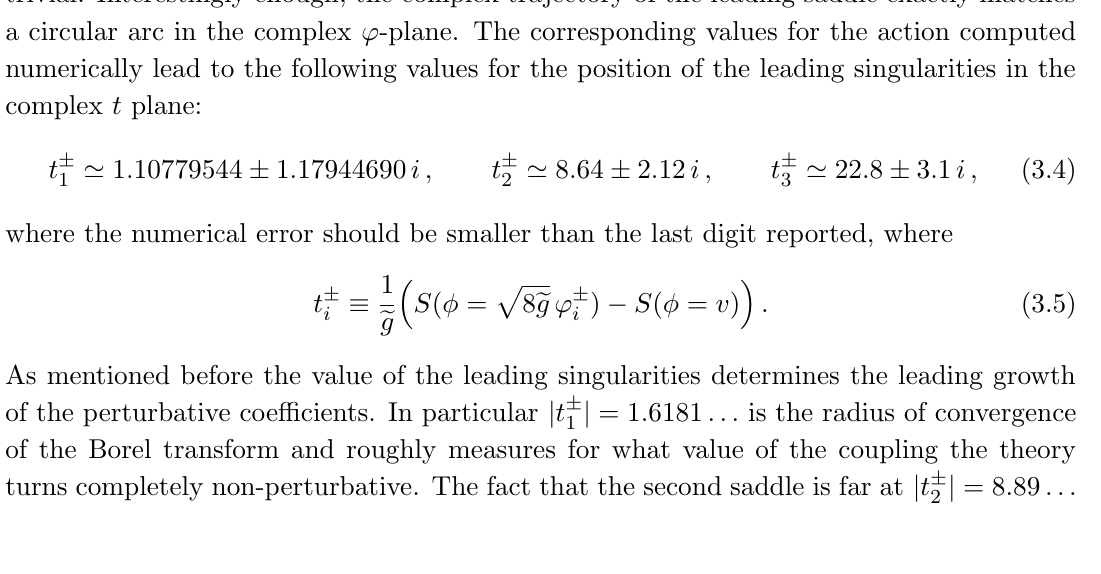
t i they are j j ’ (0) = 0 and (cid:13)ow as (cid:26) to the same r ! 1